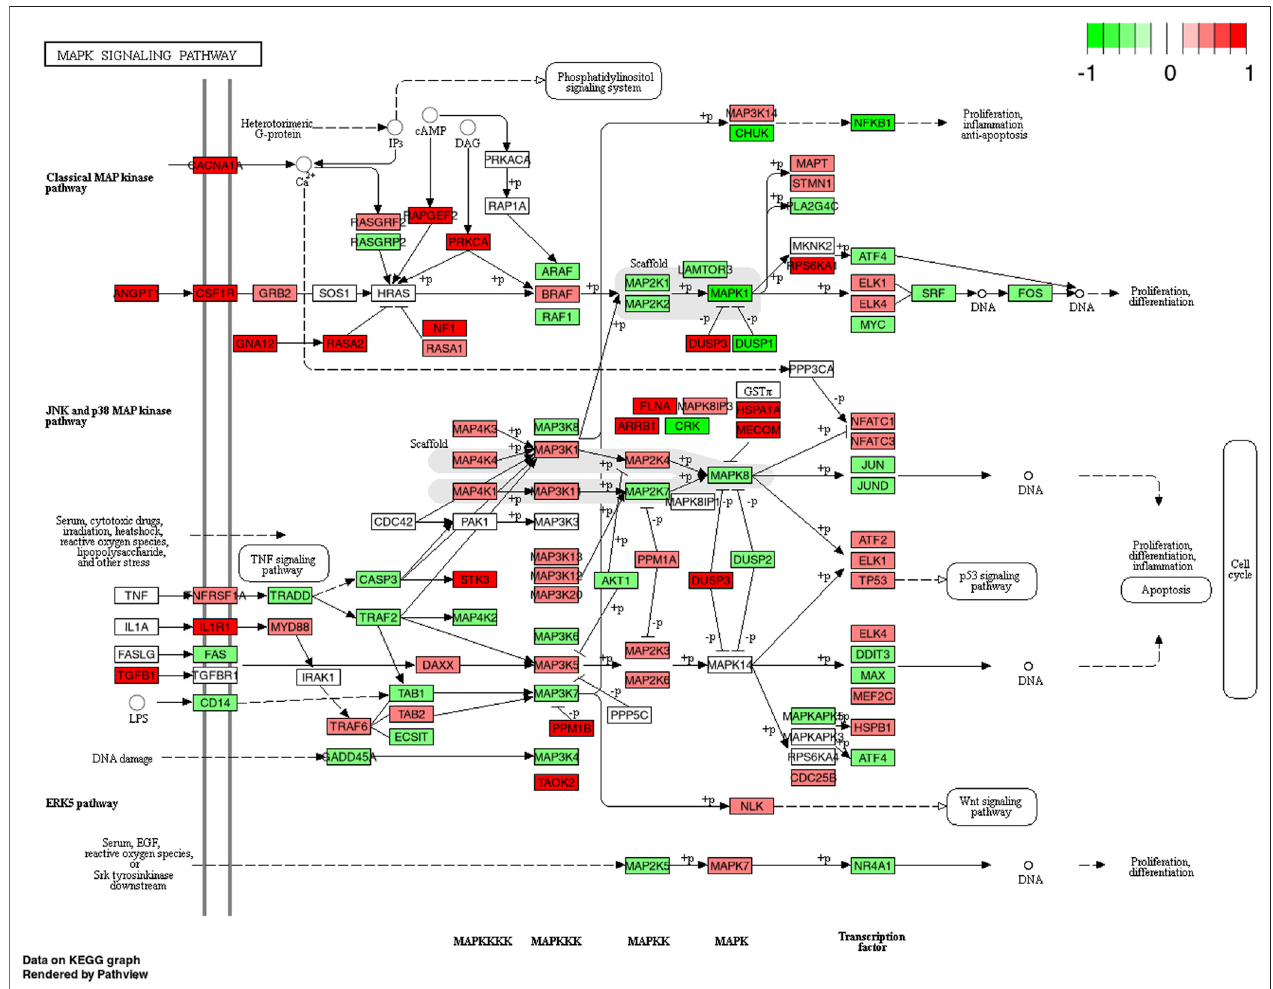
FIGURE6| KEGGpathwayoftheMAPKsignalingpathwaywithindividualgenesat4 hcomparingCP(collagenpeptides)and PLA(placebo).Colorlabelindicates genes that are up (red) or down (green) regulated compared to PLA. Dark coloring = p -value equal or below 0.05, light coloring = p -value higher than 0.05.